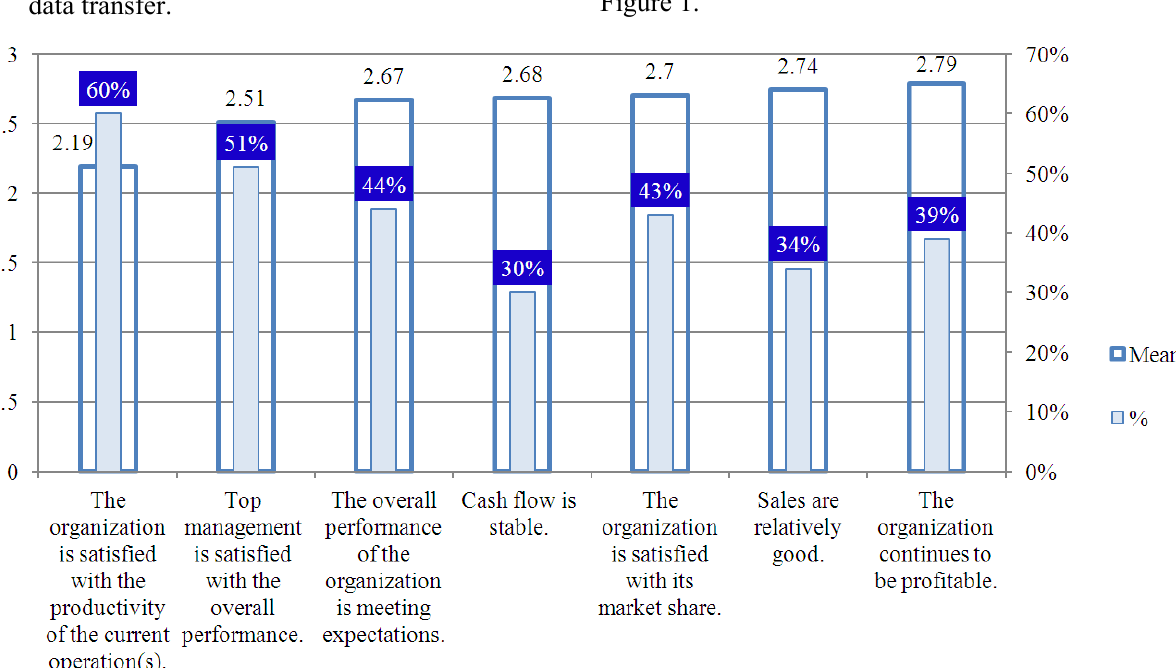
Fig. 1. Mean scores in ranking order for perceived business